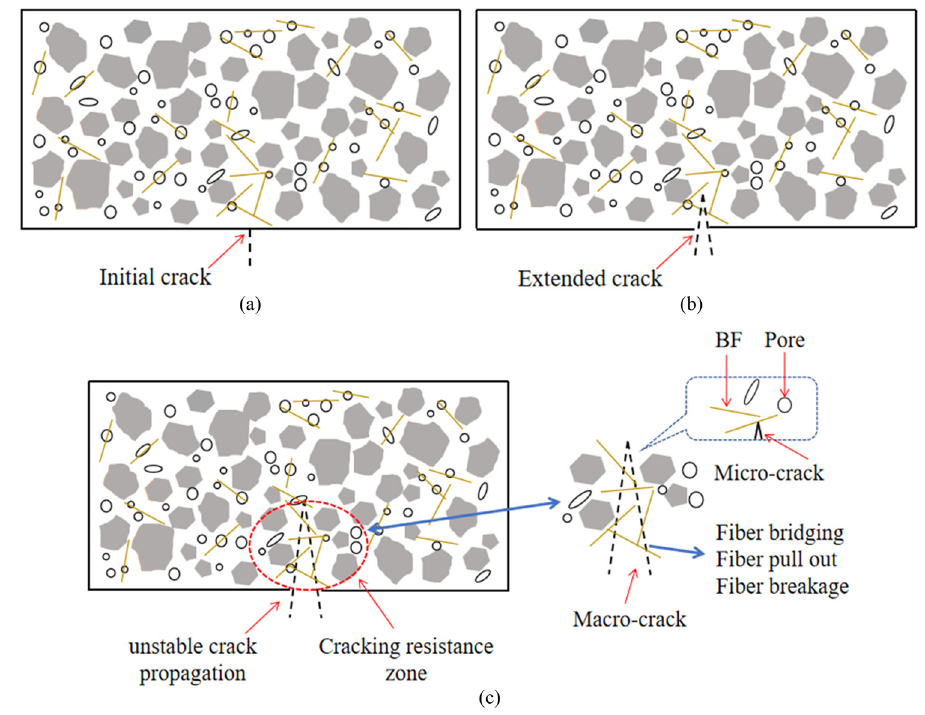
Figure 21: Flexural failure process of BFRAC. ( a ) Crack initiation process. ( b ) Crack propagation process. ( c ) Toughening and cracking resistance